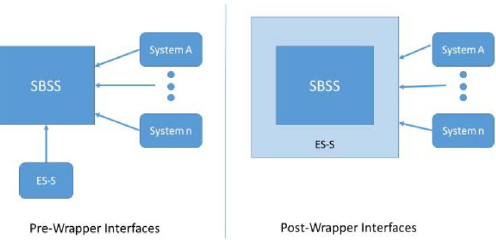
Table I. Summary of SBSS modernization objectives